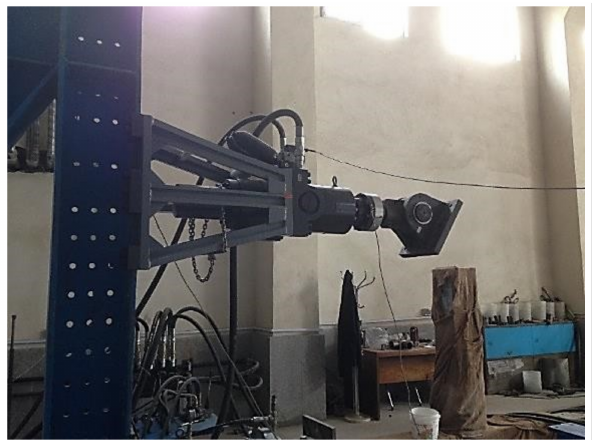
Figure 11. Servo-hydraulic